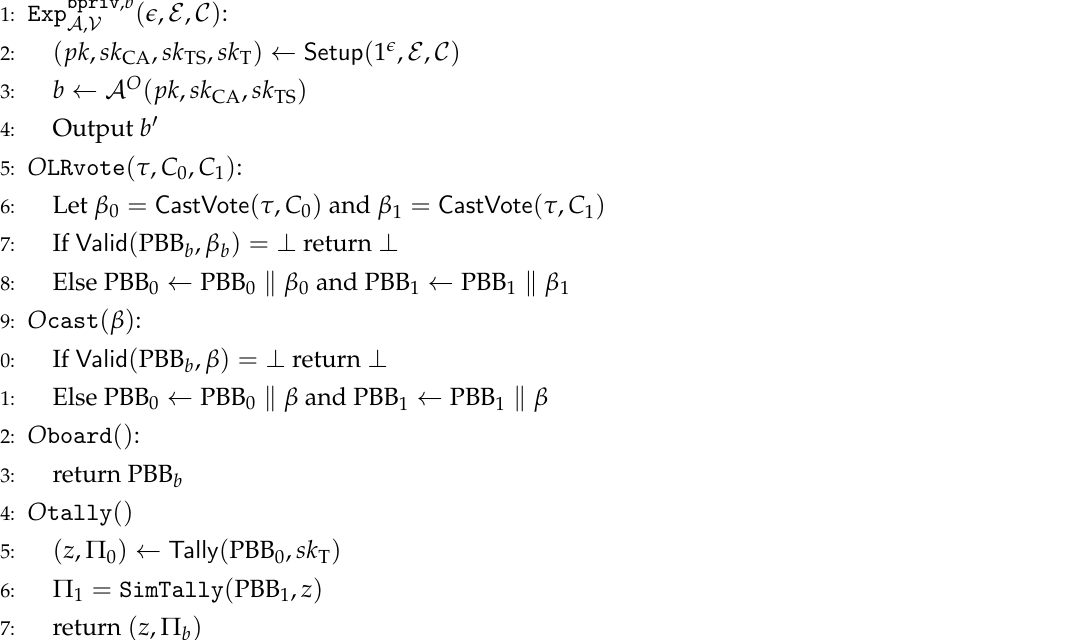
Algorithm 1 In the ballot privacy experiment Exp